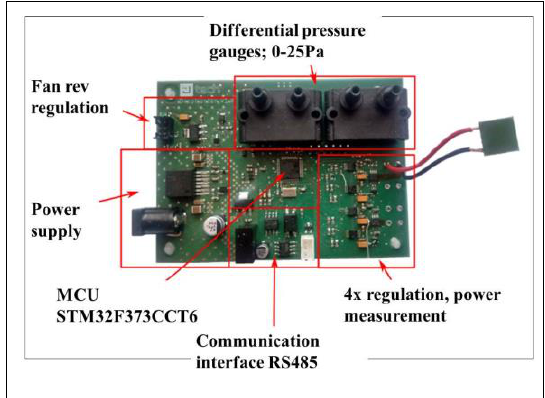
Fig. 7. PCB of the probe control unit. Apart from the heated element, it also controls the pressure gauges and the fan. The latter two components are required to comply with certain measurement conditions.